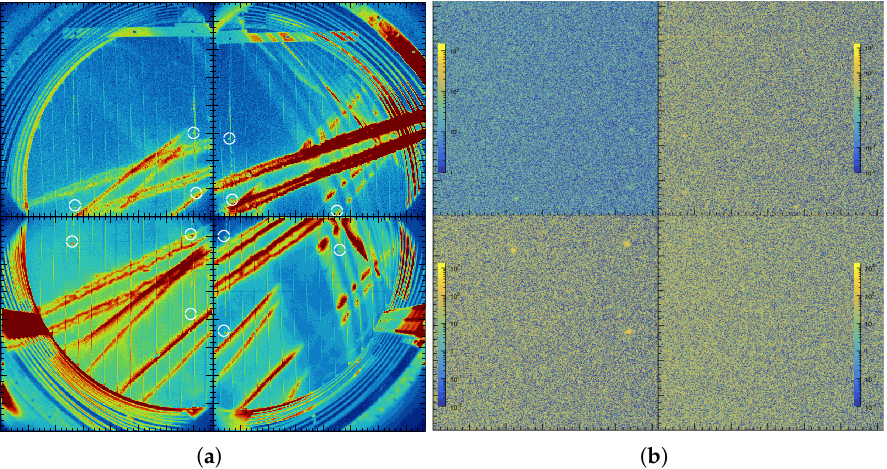
Figure 9. CCD images showing the readout plane of the HPTPC; the vertical (horizontal) image axis points along the y ( x ) direction. The color encodes the light intensity in arbitrary units. ( a ) Simul- taneously recorded frames during a spark event. The locations of the 241 Am sources (marked by circles) inside the TPC are visible during the spark event as well as the field cage rings and the anode support, cf. Figure 6b. ( b ) The light yield from the calibration sources for 200s exposure time in pure Argon at 3bar absolute pressure. The intensity of the image in the top left frame differs from the other three frames, because the corresponding camera has a different conversion